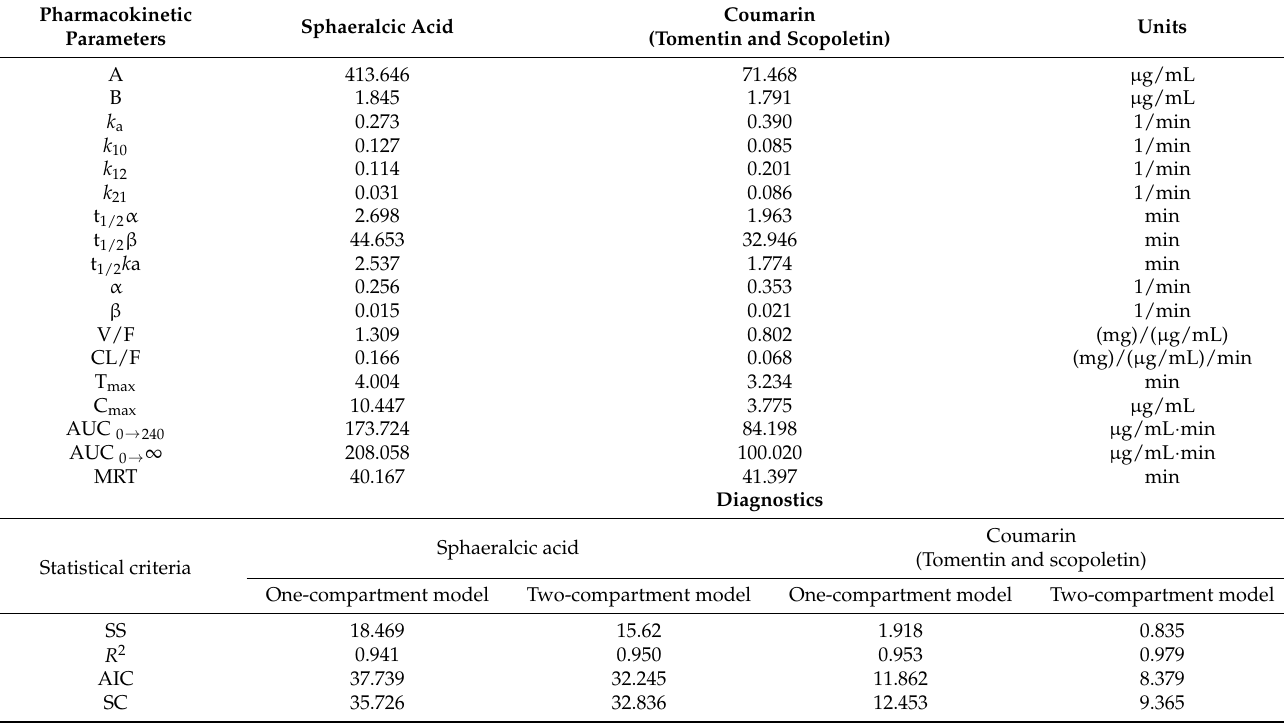
Table 4. Pharmacokinetic parameters after oral administration of the coumarins (tomentin and scopoletin) and sphaeralcic acid present in the SaTSS standardized fraction (400 mg/kg) of Sphaeralcea angustifolia in the plasma of ICR mice; n = 10. The analytes fit into the two-compartment